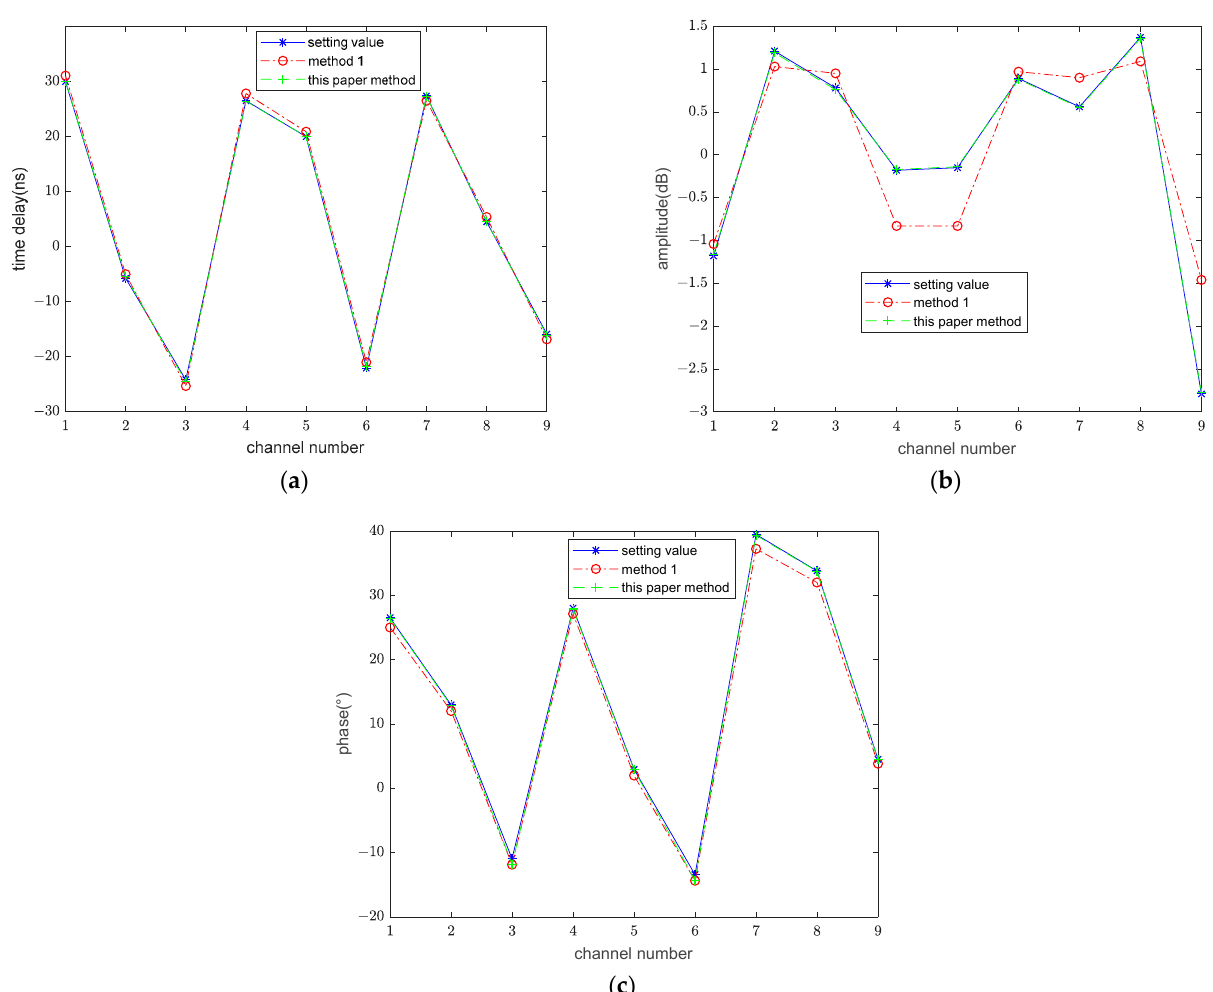
Figure 7. Comparison between the proposed method and previous methods. ( a ) Sampling time delay; ( b ) amplitude; ( c ) phase.